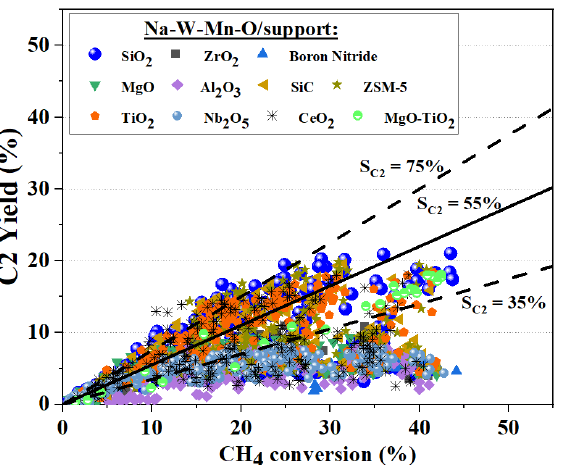
Figure 35. Experimental C2 yield as a function of CH 4 conversion reported over Na-W-Mn-O/support catalysts at different OCM reaction conditions [53,178,185–189,191]. The continuous black line denotes the slope where selectivity is 55%.